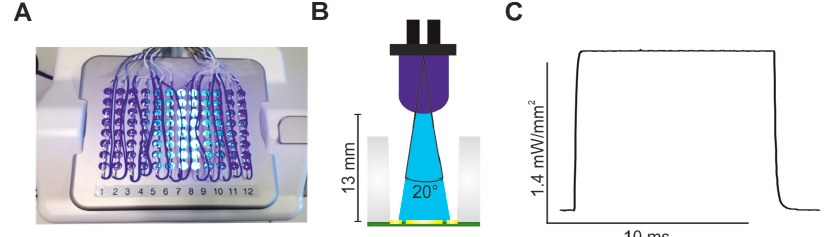
Figure 1. Custom-built prototype of a LED lid for the CardioExcyte96 system. ( A ) Picture of the lid containing 96 blue LEDs; ( B ) sketch of a single well with one LED placed 13 mm above the recording electrode (yellow) with an illumination angle of 20°; ( C ) light intensity of a 10 ms long light pulse at the level of the recording electrode.